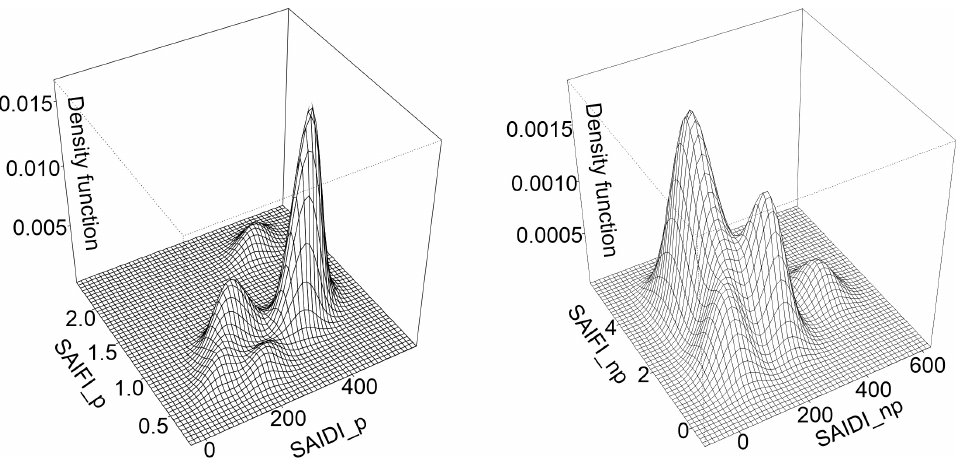
Figure 3. Graphical presentation of reliability indicators for planned (SAIDI_p, SAIFI_p) and un-